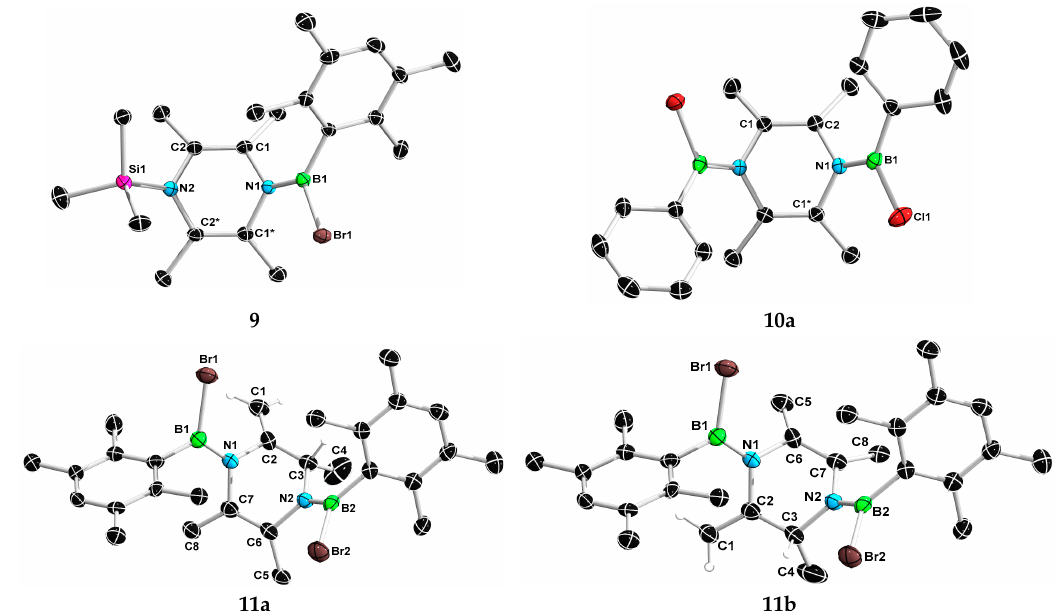
Figure 2. Molecular structures of 9 , 10a , and 11 in the solid state (ellipsoids set at 50% probability). Hydrogen atoms, except for the C(sp 3 )–H and the olefinic H in 11a and 11b , are omitted for clarity. Selected bond lengths (Å) and angles (°) for 9 : B1–N1 1.376(7), N1–C1 1.451(6), C1–C2 1.343(7), N2–C2 1.434(6), N2–Si1 1.759(5), C2–C1–N1 115.3(4), C1–N1–C1* 111.1(4); for 10a : B1–N1 1.401(2), N1–C2